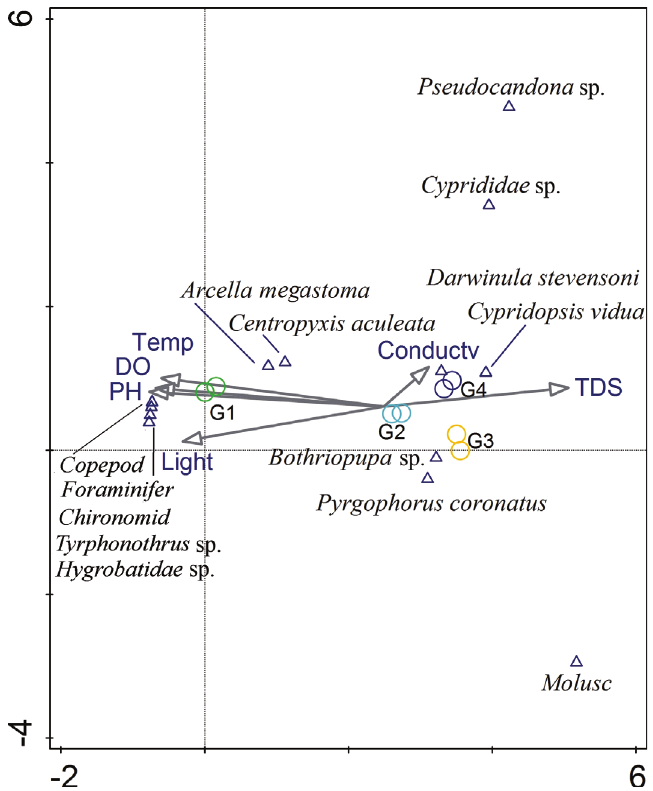
Figure 7. Detrended Correspondence Analysis (DCA) ordination diagram of benthic species and envi- ronmental variables in the cenote X-Batún. Statistical significance based on Monte Carlo test with forward selection p ≤ 0.05. Abbreviations are as follows: temperature (Temp), dissolved oxygen (DO), conductiv- ity (Conductv), total dissolved solids (TDS). G1 assemblage of surface sediments; G2 assemblage of open water sediments; G3 assemblage of cavern; G4 assemblage of cave sediments identified in NMDS. Colors corresponded to that in the NMDS